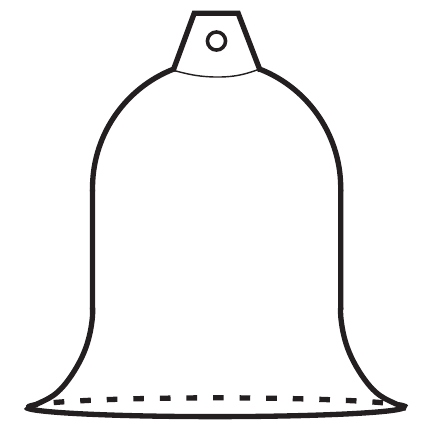
Figure 1. Schematic of a traditional Chinese bell.